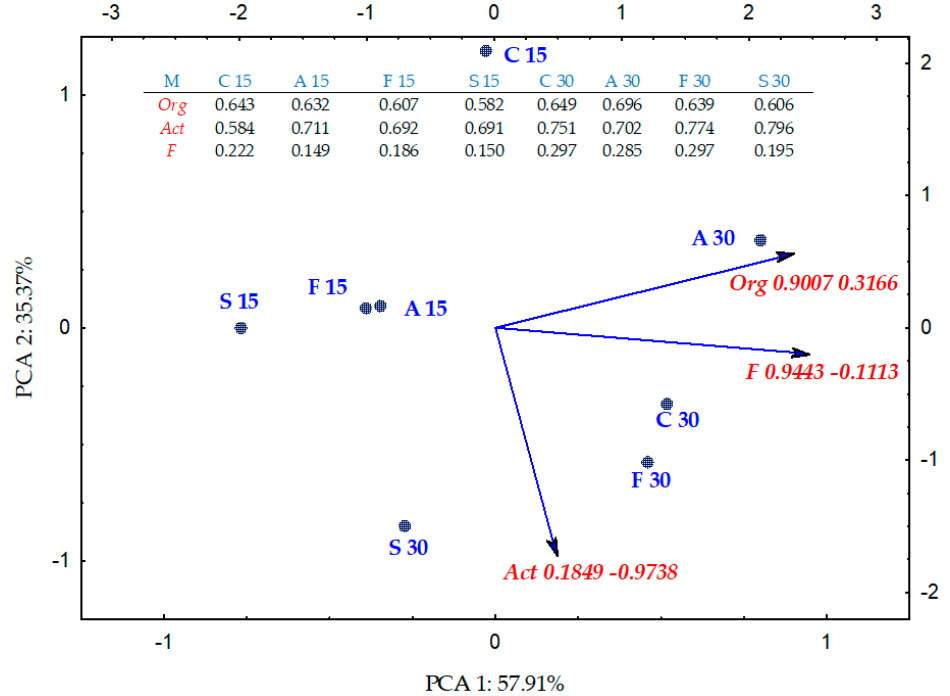
Figure 5. Ecophysiological diversity factor (EP) for Org—organotrophic bacteria, Act—Actinomycetes and F—fungi in soil contaminated BPA, BPF and BPS on the 15th and 30th day of research—PCA method; M—groups of microorganisms; C—control; A—soil contaminated with BPA; F—soil contaminated with BPF; S—soil contaminated with